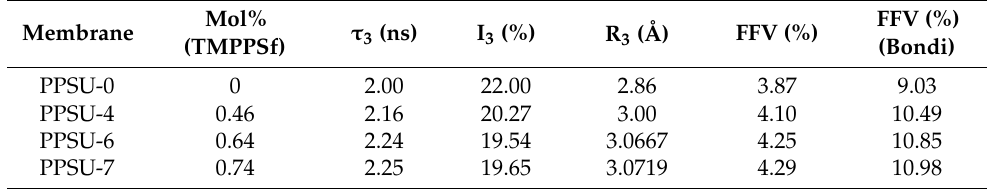
Table 2. PALS data of membranes.